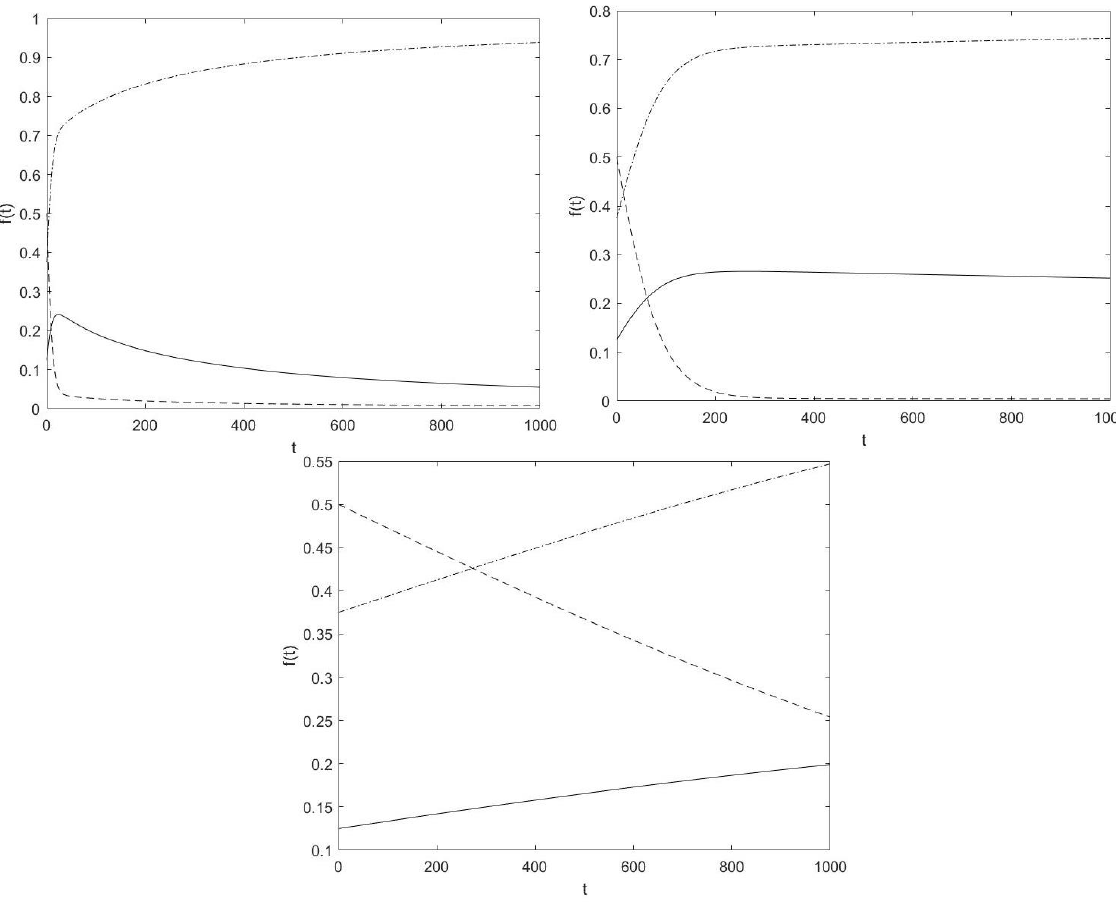
Figure 1. From top left to bottom η = 1, η = 3, γ = 6. f 1 dot-dashed, f 2 dashed, f 3 full.